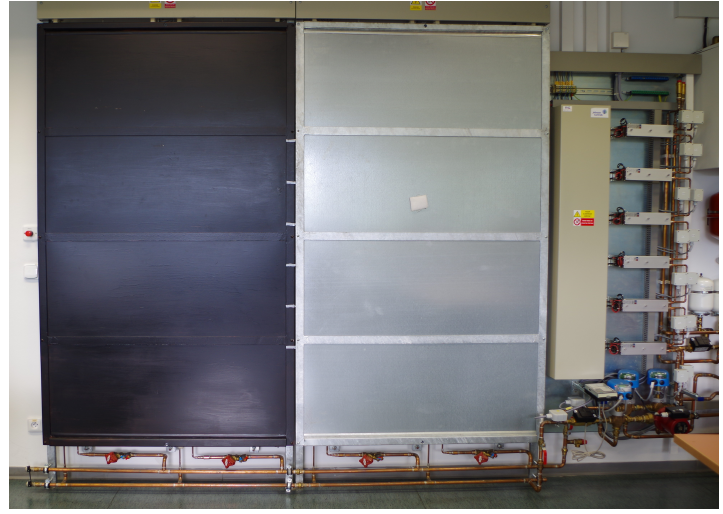
Figure 3. Accumulation device and thermoelectric assembly on the